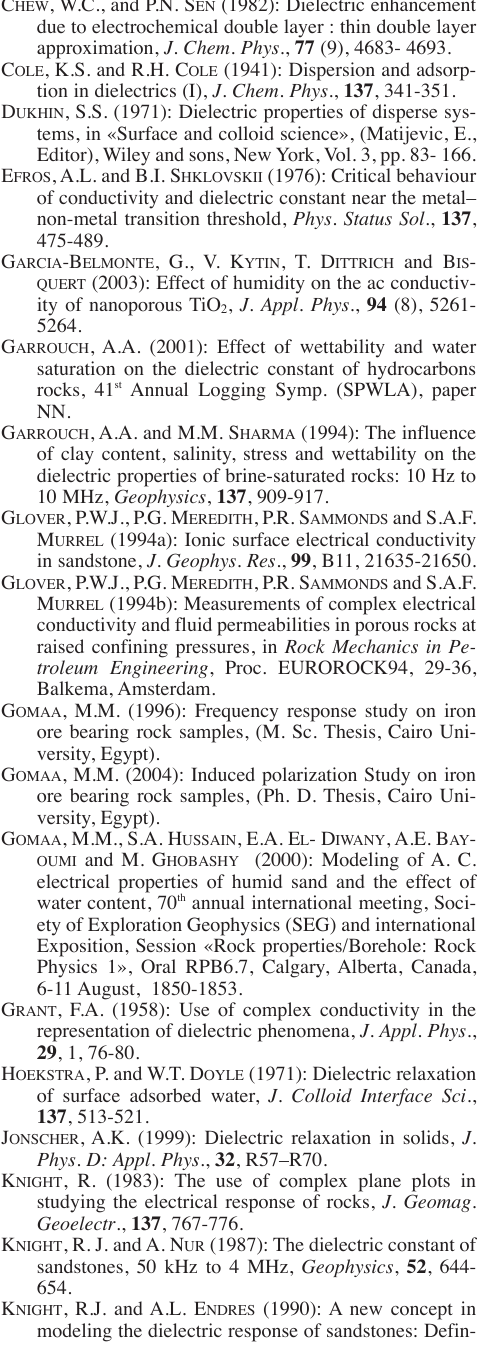
Fig. 8. The complex resistivity plane representation of the sample for relative saturations 50% ( ), 55% ( ),